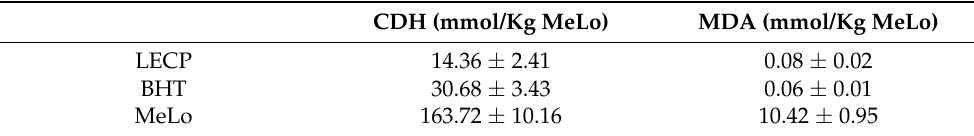
Table 4. Results of antioxidant activity of LECP and